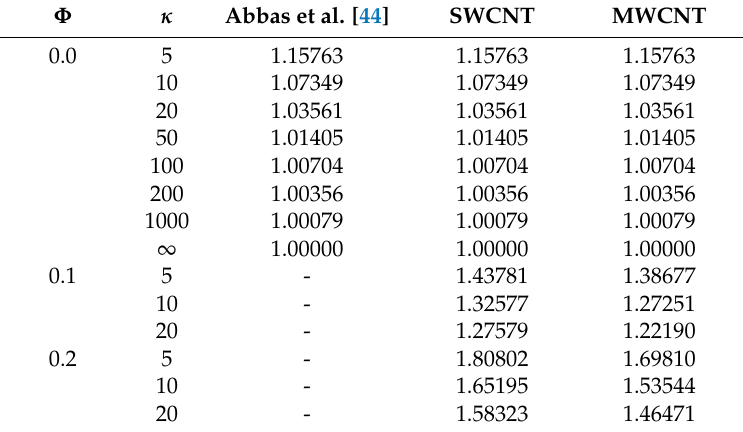
C f and Re − 1/2 Nu s ∗ for different values of Φ and λ by setting Rd = 0 s ∗ s ∗